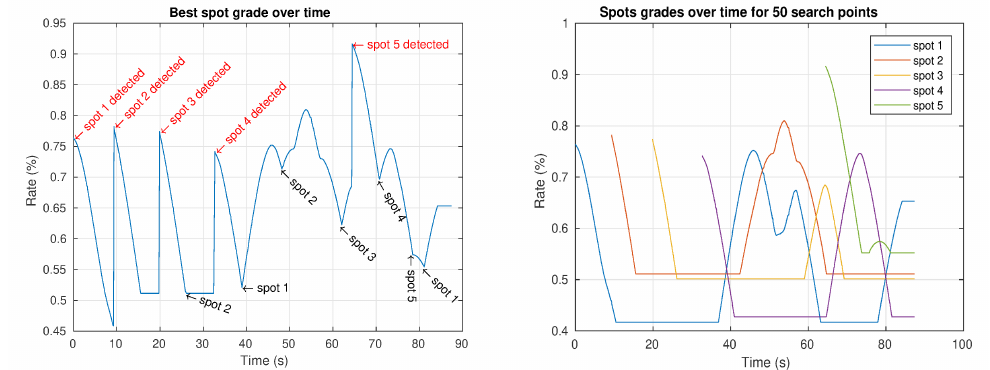
Figure 11. Grades of the best spot and each spot detected for 50 search